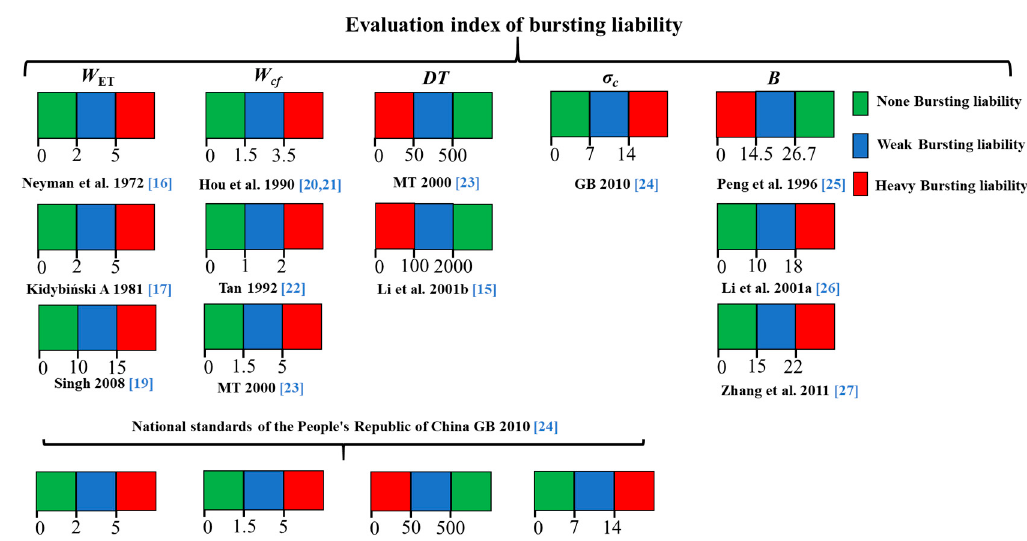
Figure 1. Main bursting liability indices and their classification standards.